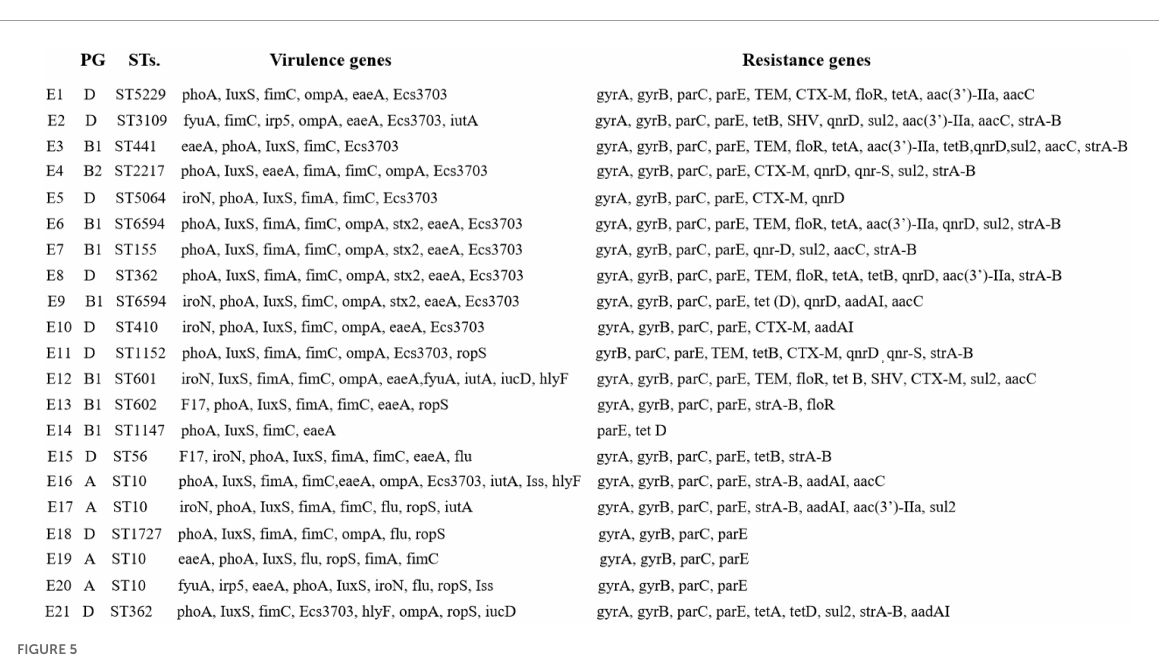
resistant to amikacin in calves with E. coli in Egypt (Algammal et al., 2020). The resistance rates of E1–E21 to polymyxin B and cotrimoxazole were 5 and 48%, respectively. This finding